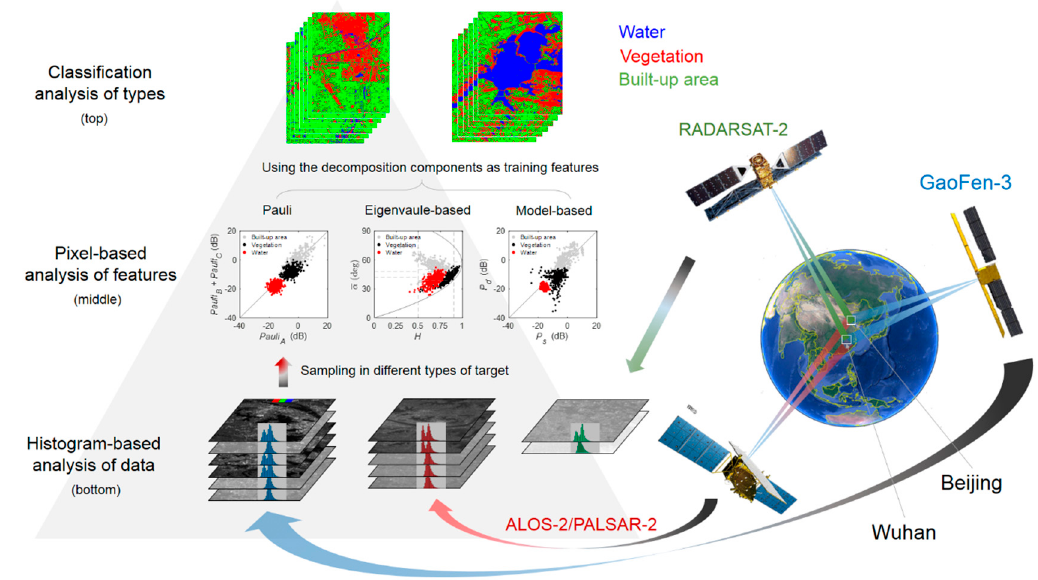
Figure 1. A three-hierarchy framework to evaluate the quality of polarimetric SAR data.